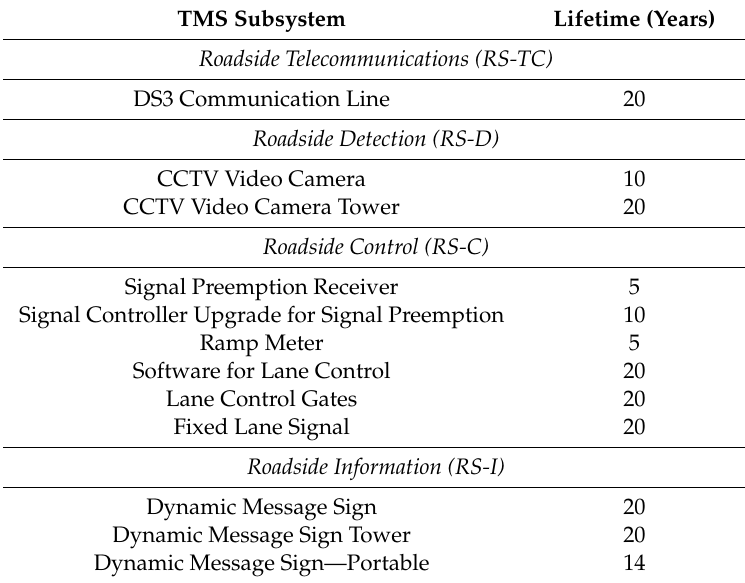
Table 1. Tra ffi c management system (TMS) subsystem components and lifetime, Vick and Sumner [9].